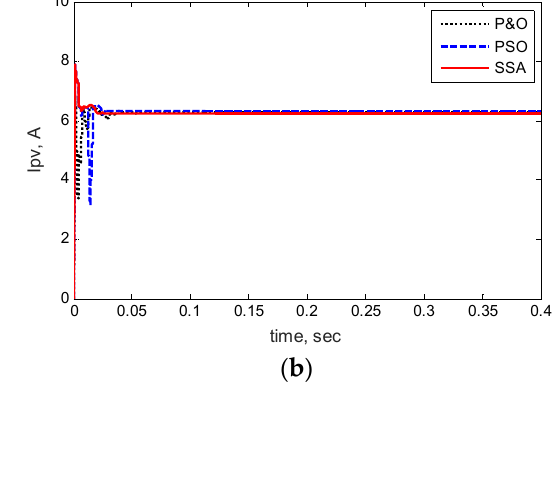
Figure 10. Photovoltaic panel tracking curves using P&O, PSO and SSA methods in the condition of shade pattern 1: ( a ) Vpv, ( b ) Ipv, ( c ) Ppv, ( d ) duty cycle.